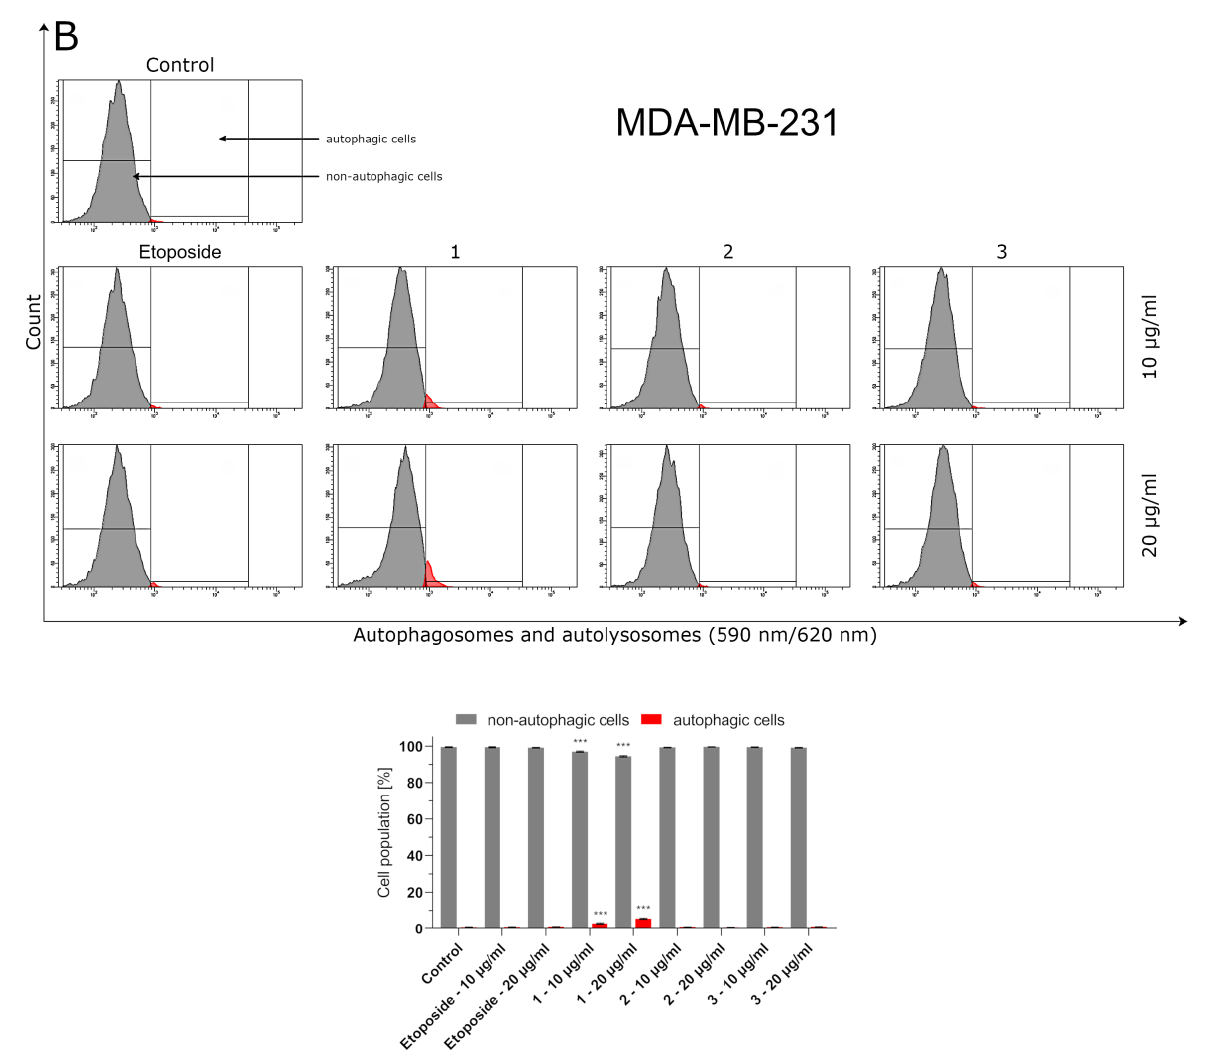
Figure 5. Autophagy induction in MCF-7 ( A ) and MDA-MB-231 ( B ) breast cancer cells measured by flow cytometry using an autophagy probe (red color) compared to negative control cells (gray color) after 24 h of incubation with compounds 1 – 3 and etoposide. The compounds were tested at the following concentrations: 1 (10 µ g/mL/23.83 µ M and 20 µ g/mL/47.66 µ M), 2 (10 µ g/mL/22.75 µ M and 20 µ g/mL/45.50 µ M), 3 (10 µ g/mL/23.78 µ M and20 µ g/mL/47.56 µ M), etoposide (10 µ g/mL/17 µ M and 20 µ g/mL/34 µ M). Mean percentage values from three independent experiments (n = 3) performed in duplicate are presented. *** p < 0.001 vs. control group .